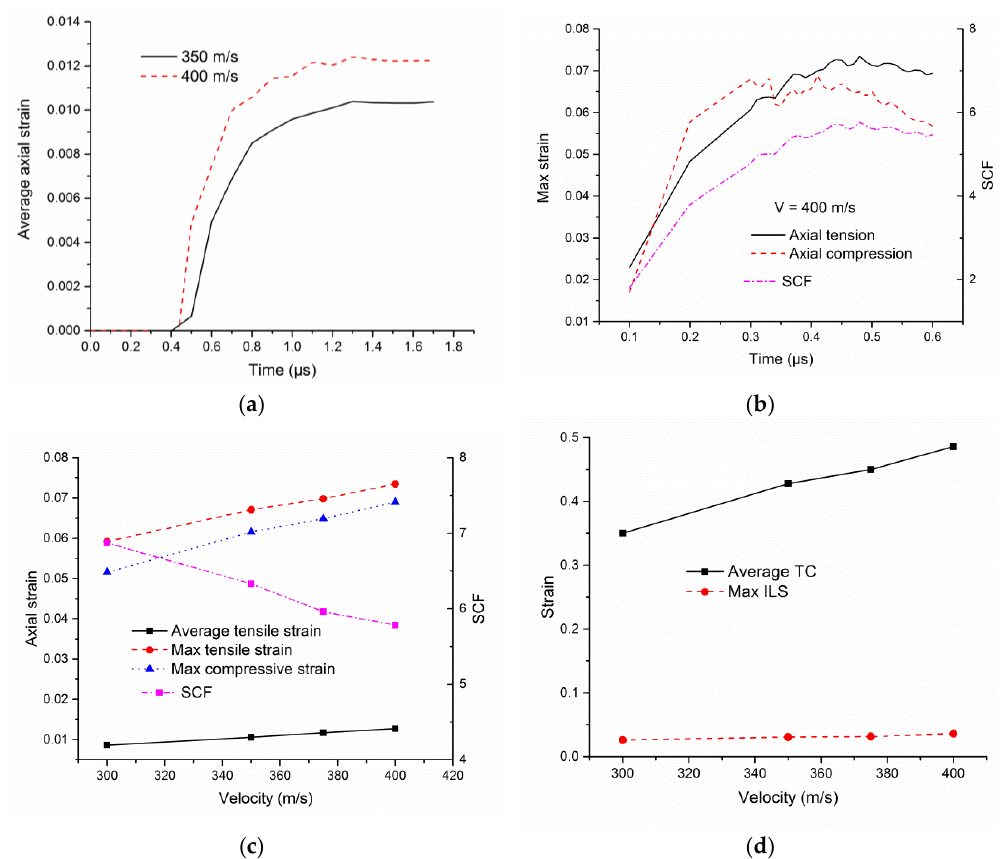
Figure 9. Cylindrical impact inelastic fiber behavior: ( a ) evolution of average axial strains; ( b ) evolution of axial tensile and compressive strains; ( c ) axial strain and SCF as a function of velocity; and ( d ) TC strain as a function of velocity.